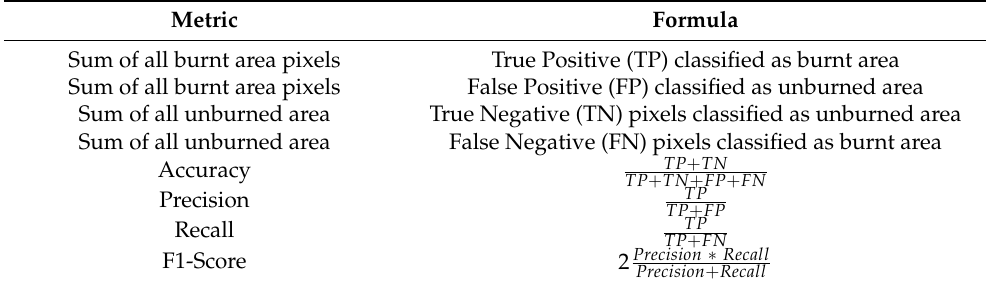
Table 3. Evaluation metrics presented in this study. Metric